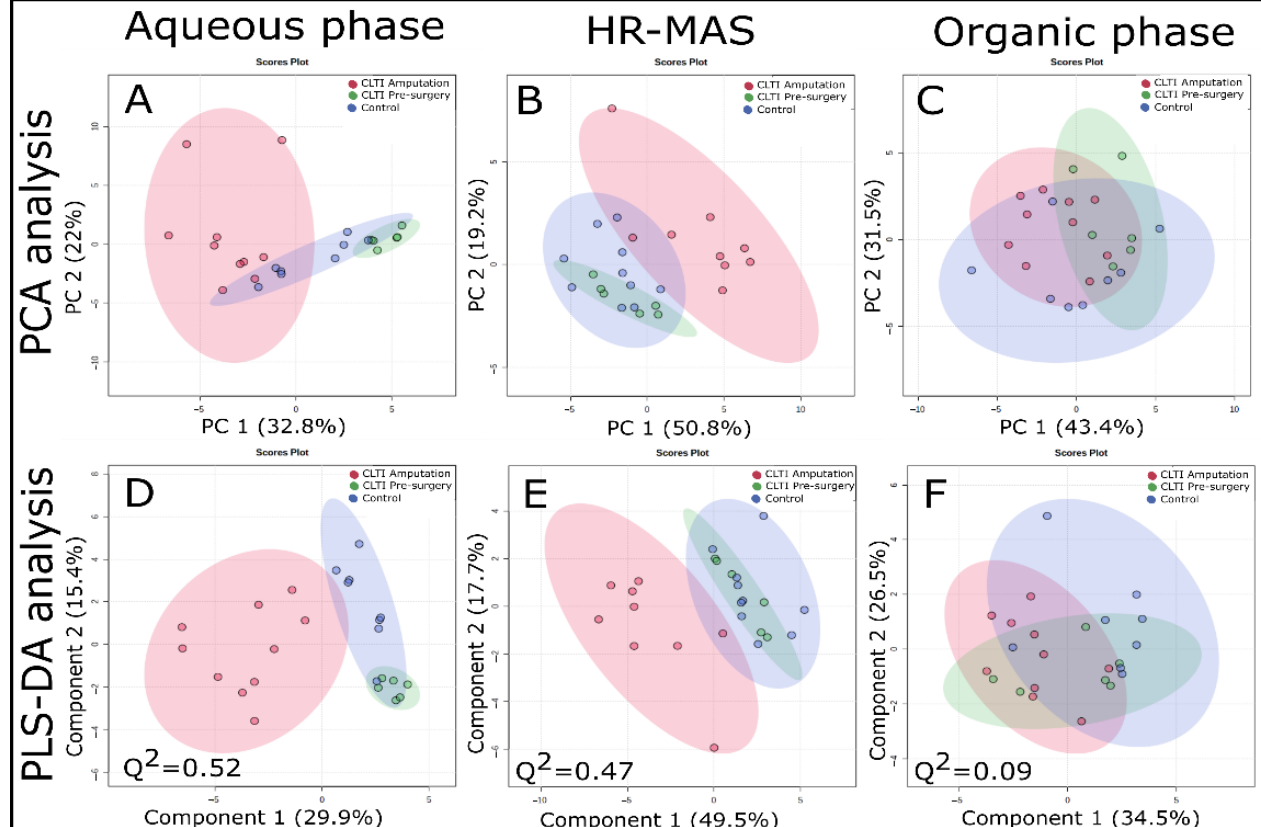
Figure 3. PCA and PLS-DA analyses data obtained for three different groups of human gastrocnemius samples using solution state 1 H NMR and HR-MAS spectroscopy. Top row ( A – C ) were obtained from PCA analysis and bottom row ( D – F ) were from PLS-DA analysis. ( A , D ) are for aqueous phase samples (from FOLCH extraction) for PCA and PLS-DA analyses, respectively; similarly, ( B , E ) are for HR-MAS on intact tissue for PCA and PLS-DA analyses, respectively; and ( C , F ) are for organic phase (from FOLCH extraction) for PCA and PLS-DA analyses, respectively. CLTI Amputation (red), CLTI Pre-surgery (green), and control (blue).